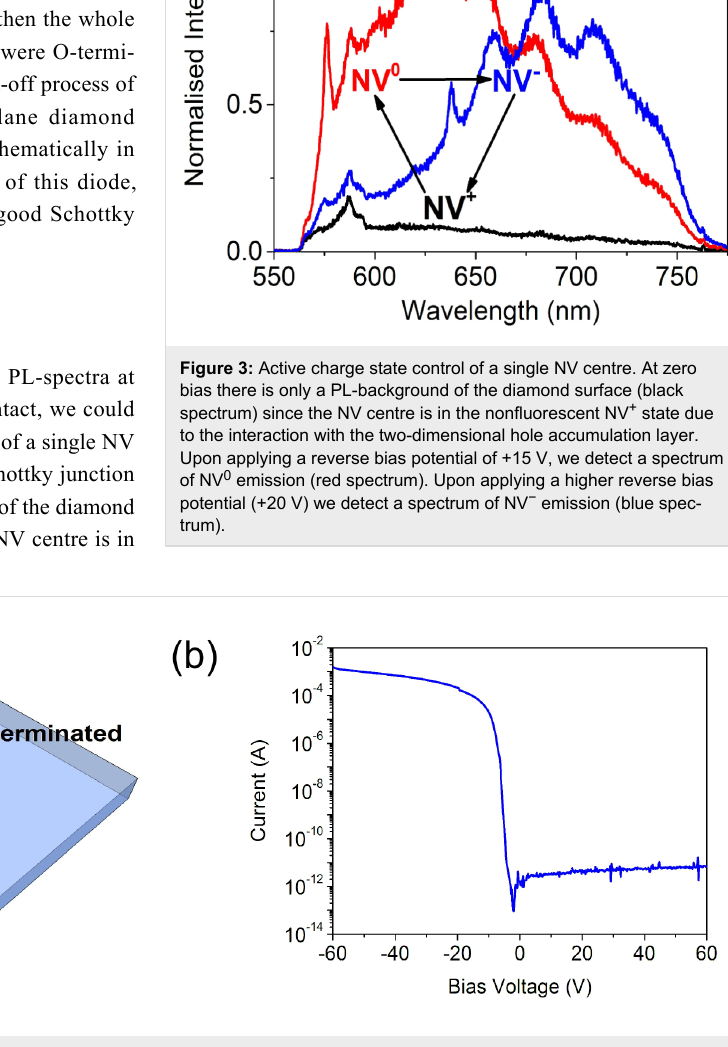
Figure 2: In-plane Schottky diode from diamond. (a) Schematic figure of an in-plane Al Schottky diode on an H-terminated diamond surface. (b) The current–voltage properties of the fabricated in-plane Al-Schottky diode measured at ambient conditions.